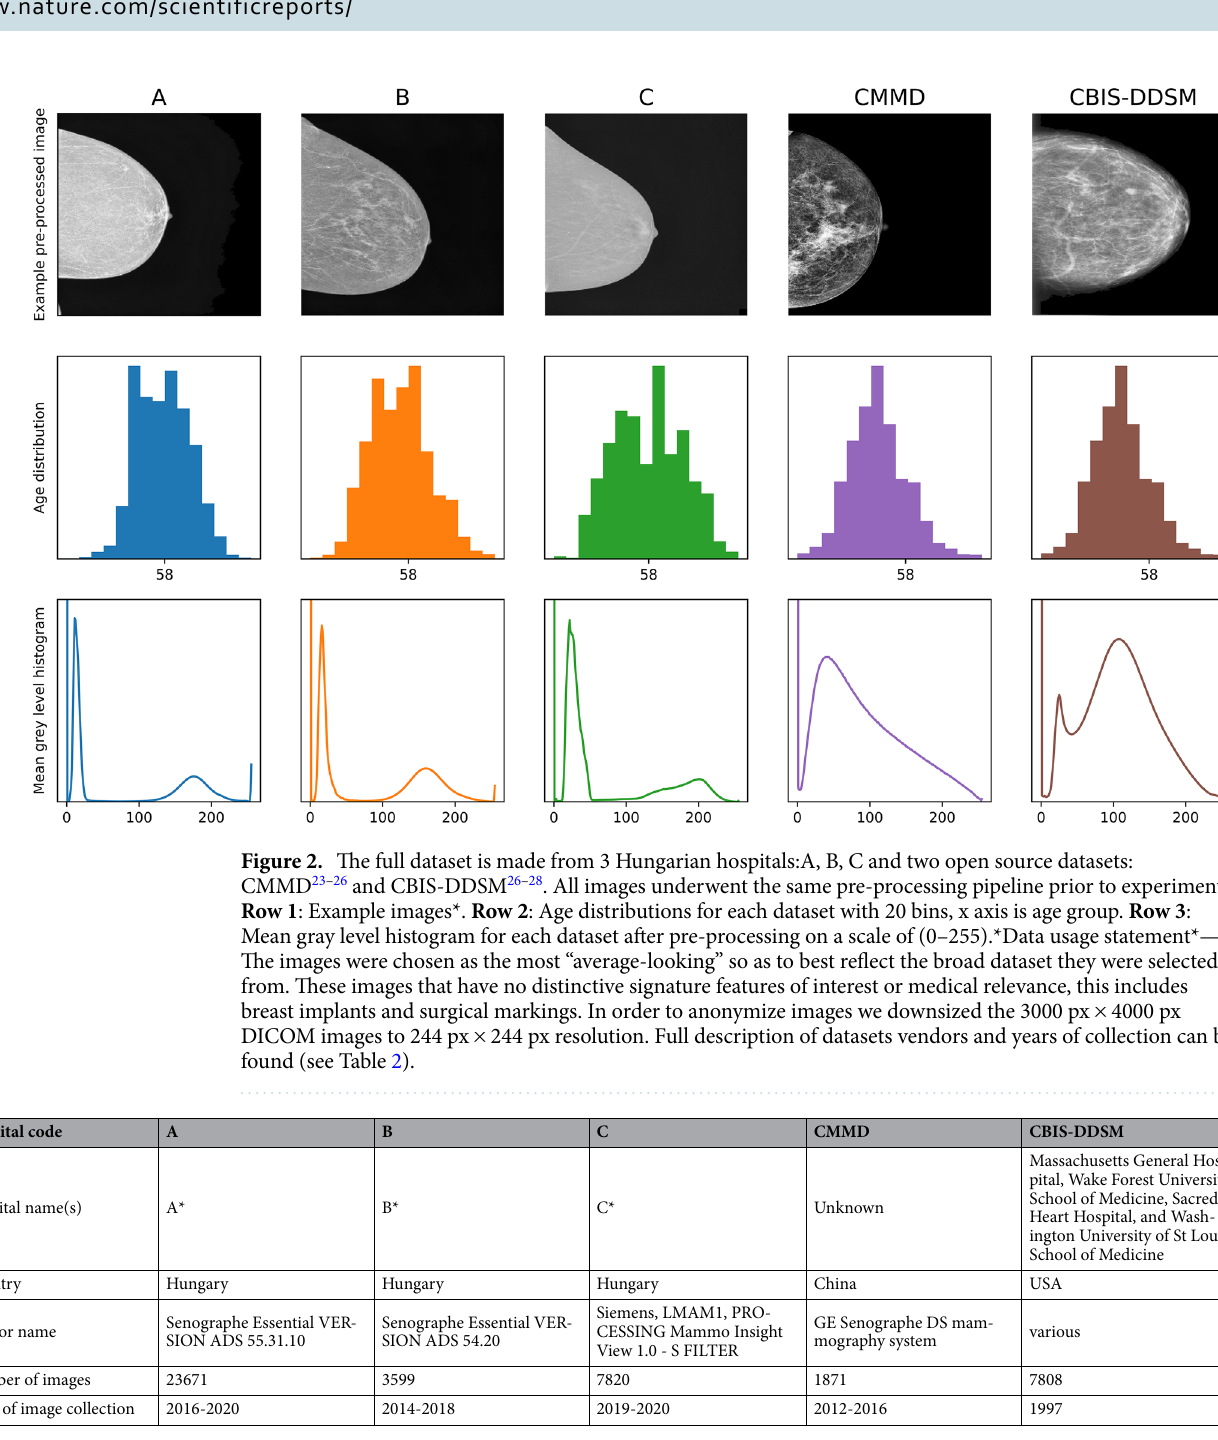
Table 2. In depth description of data sources. * Hospital names are